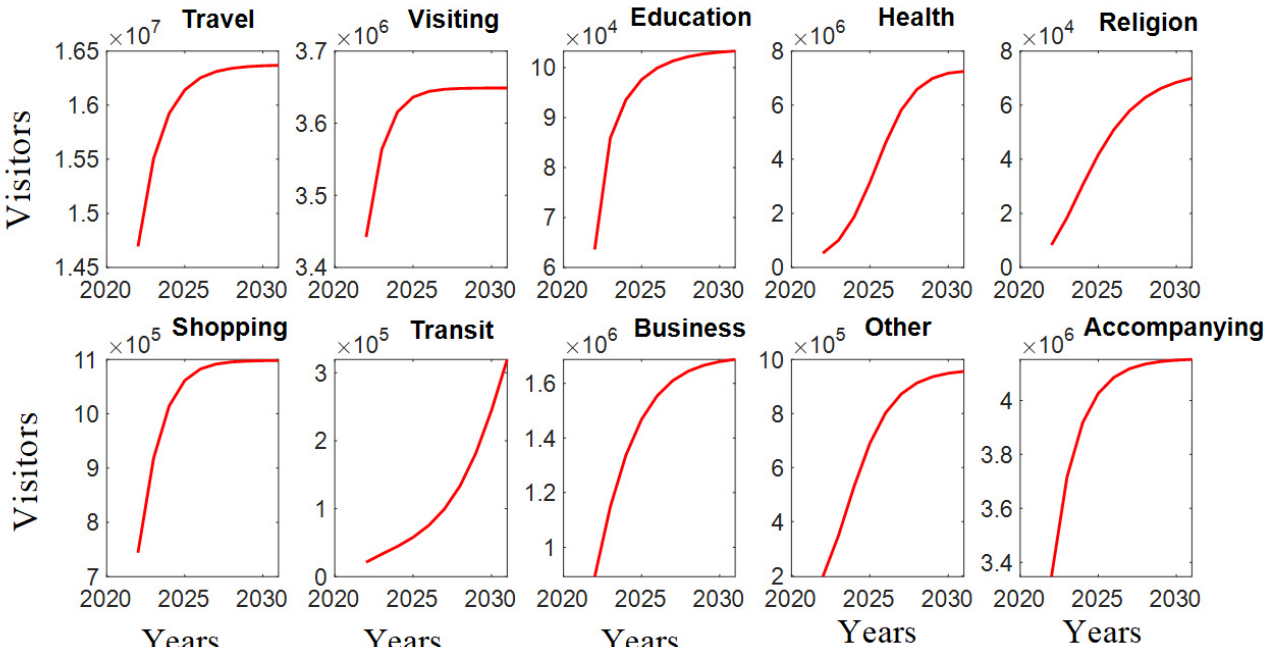
Figure 5. Future predictions of the departing foreign visitors by reasons in Türkiye.